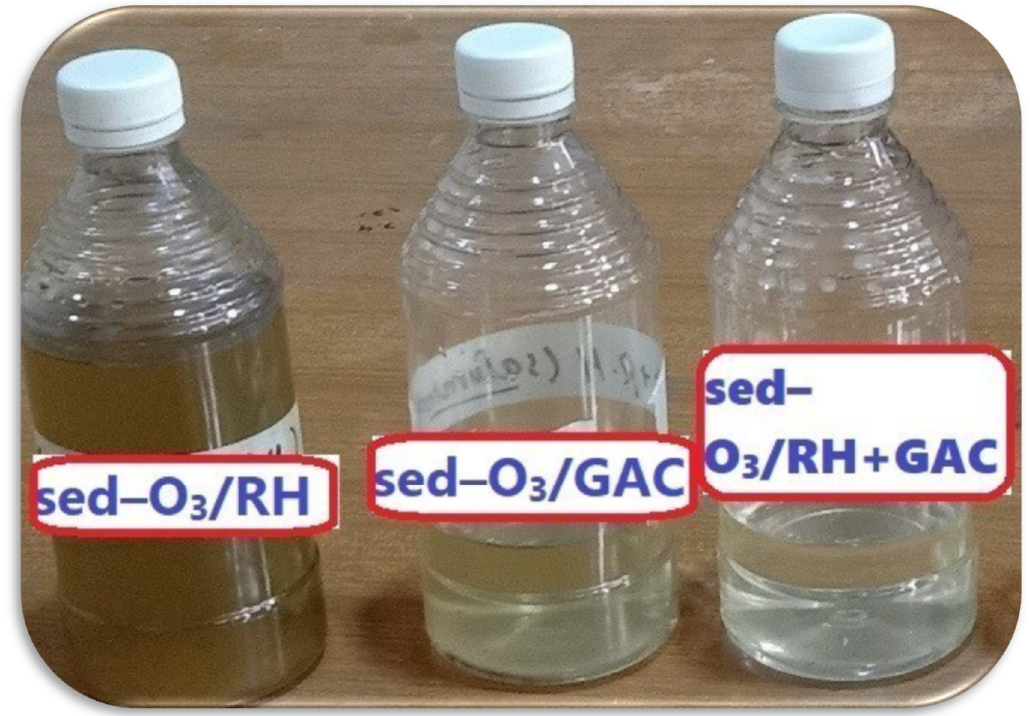
Figure 5. Treated samples of ASSWW by three treatment combinations.